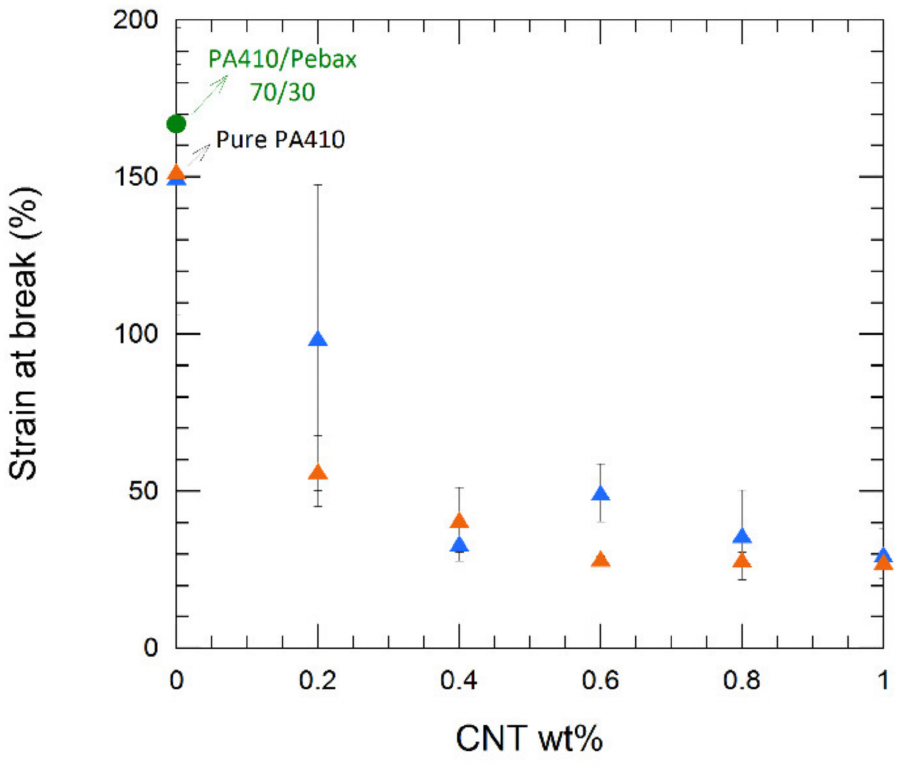
Figure 11. Strain at break of PA410/Pebax/CNT ( (cid:78) ) and PA410/PA6/Pebax/CNT ( (cid:78) ) NCs vs. the CNT content. Pure PA410 and the PA410/Pebax2 70/30 blend have been represented as a